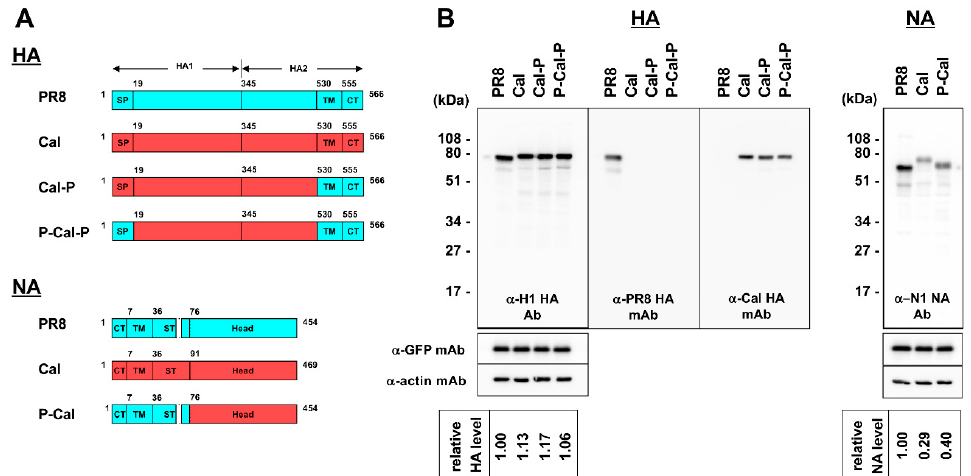
Figure 1. Schematic diagram and expression of chimeric HA and NA proteins. ( A ) Schematic diagram of chimeric HA and NA proteins. Domains derived from A / Puerto Rico / 8 / 34 (H1N1) virus (designated as PR8) are shown as light blue boxes and that of A / California / 07 / 09 (H1N1) virus (designated as Cal) as red boxes. Designations of chimeric HA and NA are shown to the right of constructs. SP—signal peptide; TM—transmembrane; CT—cytoplasmic tail. The amino acid numbers are shown in diagrams. ( B ) Expression of chimeric HA and NA proteins. MDCK cells were cotransfected with an HA or NA expression plasmid and an EGFP expression plasmid. Protein expression was analyzed by Western blotting with anti-H1 HA rabbit Ab, anti-PR8 HA mAb, anti-Cal HA mAb, and anti-NA sheep Ab. The blots were also probed with anti-GFP and anti-actin mAbs. Representative blots are shown. The band intensities were semi-quantified with ImageJ software.